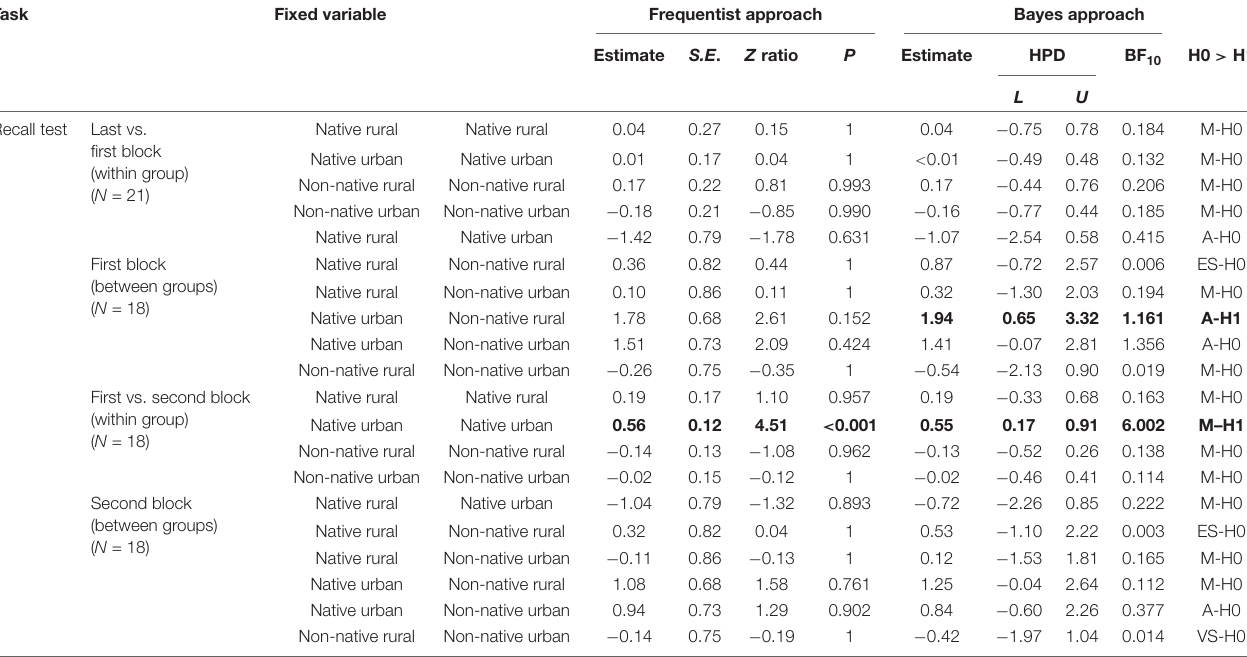
Recall test Last vs. first